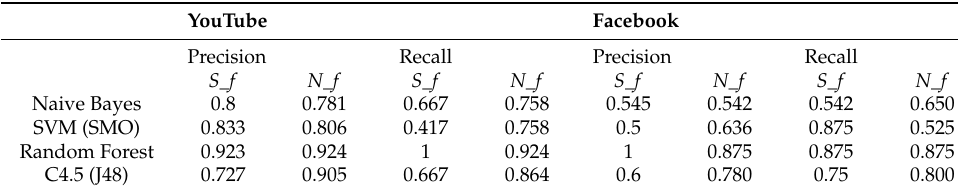
Table 5. Precision and recall results for each